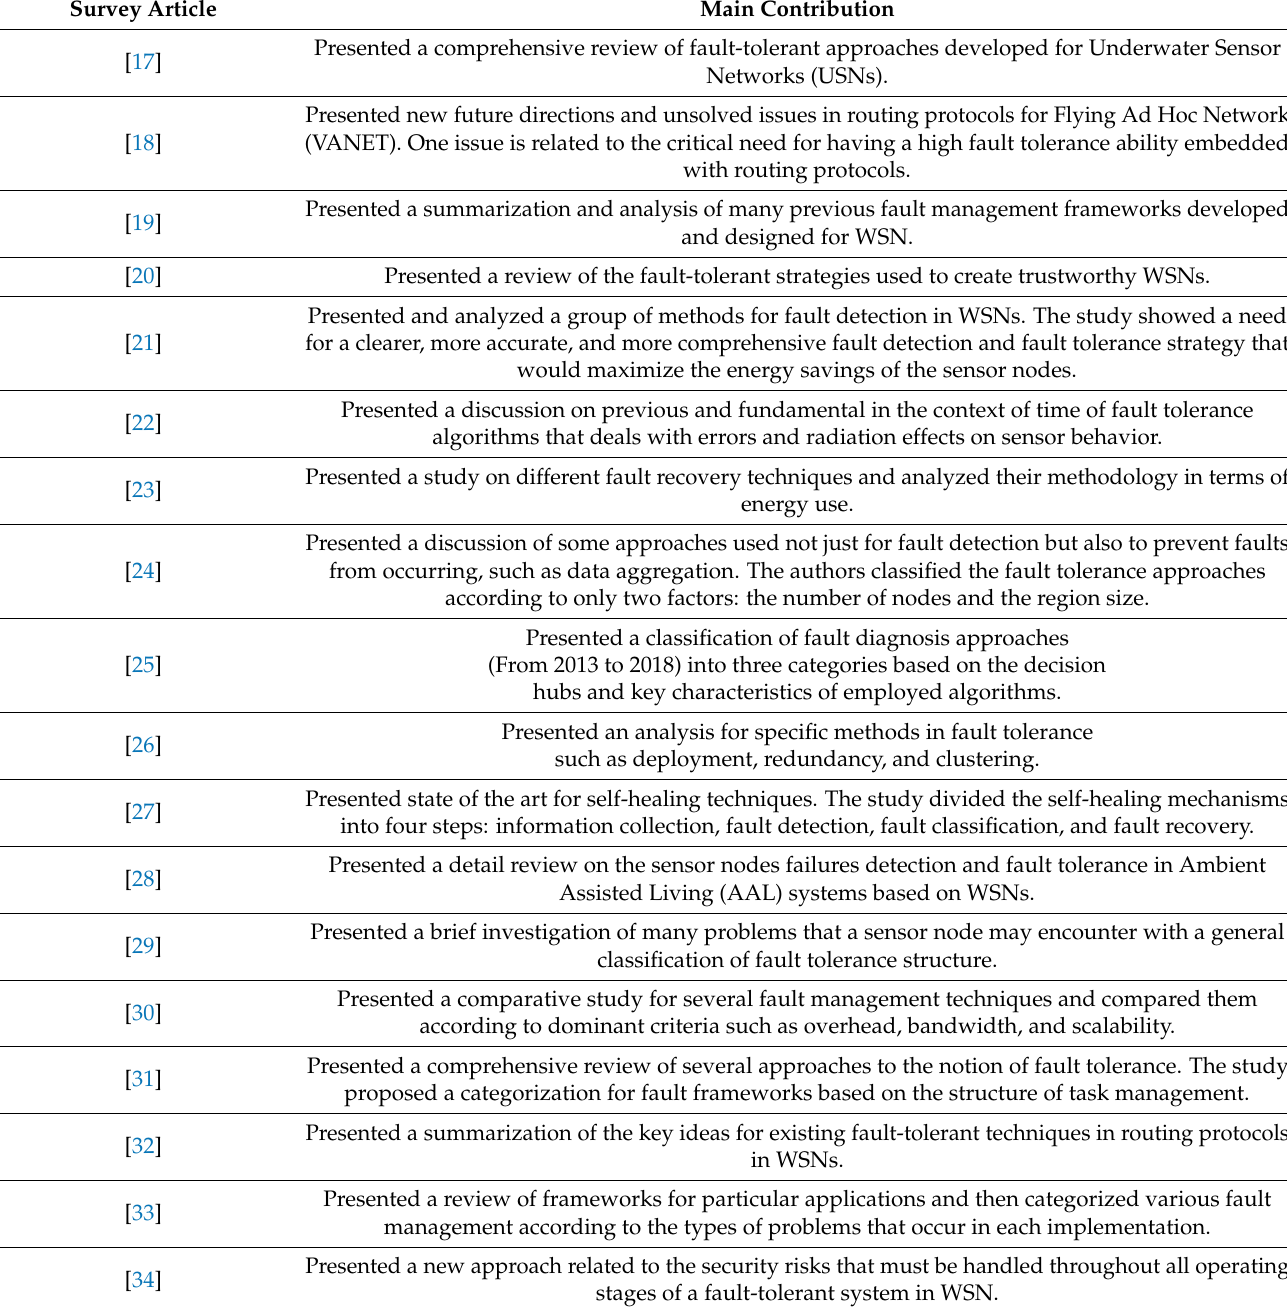
Table 2. Surveys Classifications based on Year, Citation, and Main